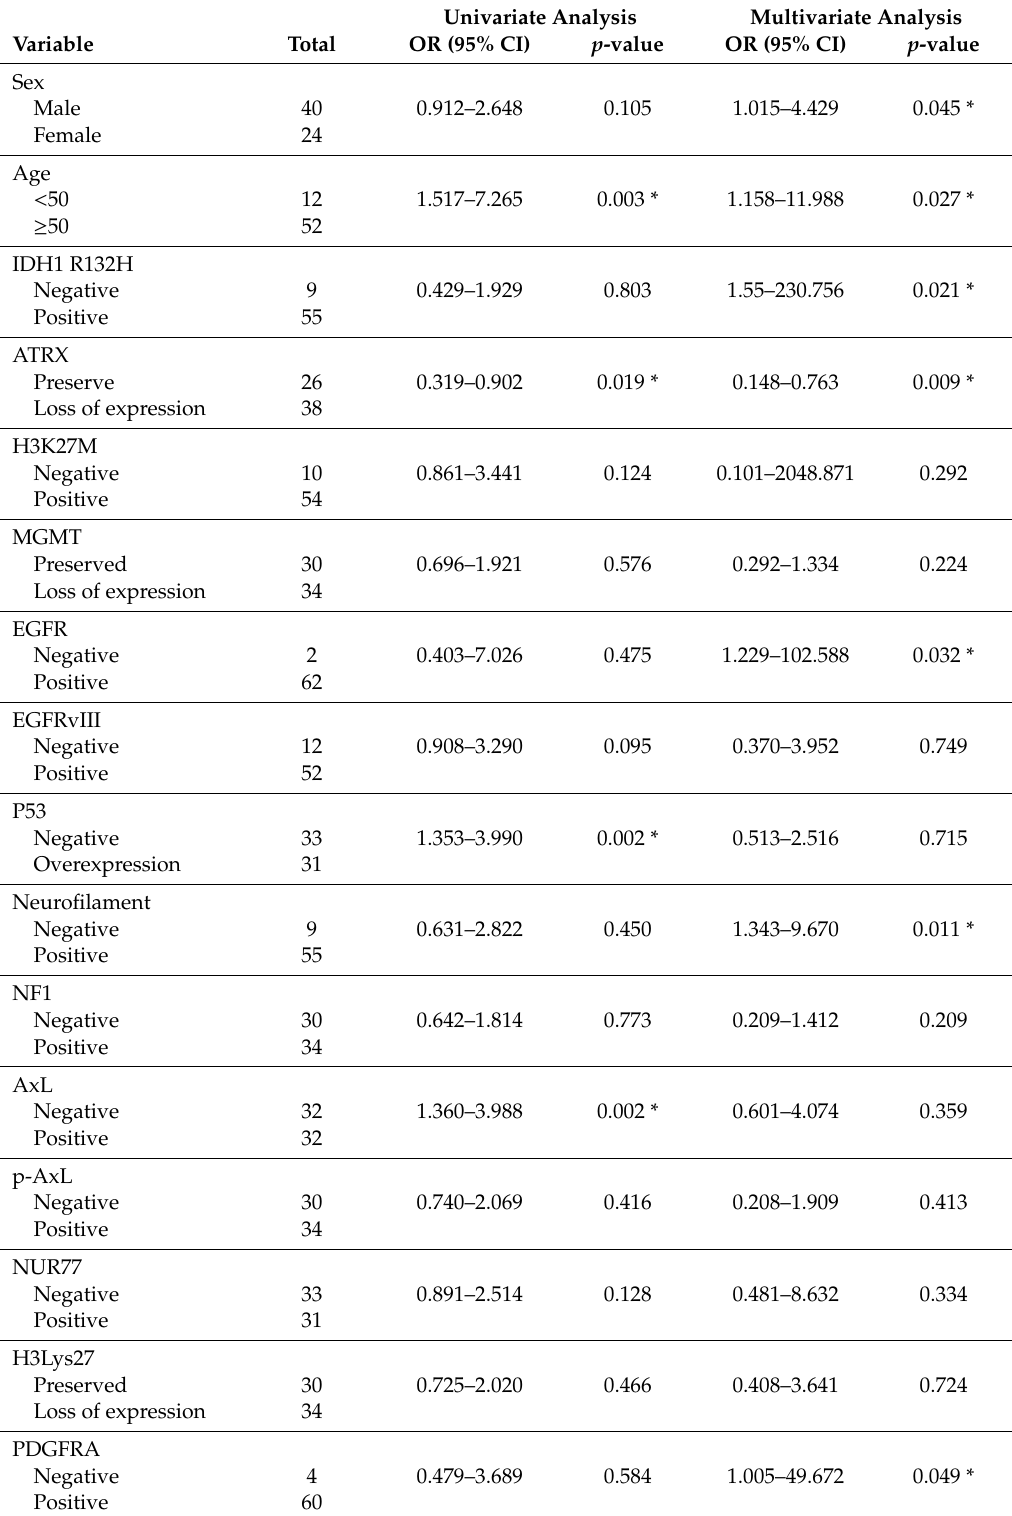
Table 1. Statistical analyses for ALDOC and clinical parameters expression in brain tumors. Univariate Analysis Multivariate